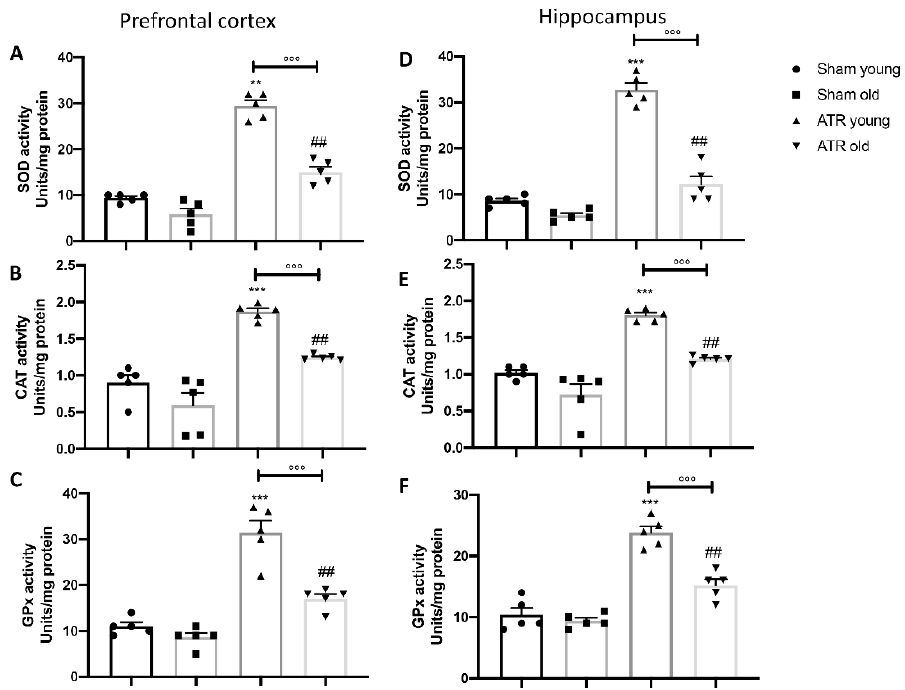
Figure 6. Effect of ATR inhalation on SOD, CAT and GPx activity. By ELISA kit we investigated the effect of ATR inhalation on SOD, CAT and GPx activity in prefrontal cortex ( A–C ) as well as in the hippocampus ( D–F ). After ATR exposure, both young and aged mice showed a significant increase in physiological antioxidant response in prefrontal cortex and hippocampus. Statistical analysis revealed that older mice showed less physiological response than younger mice. Data is expressed as the mean ± SEM of n = 5 animals for each group. ** p < 0.01 vs. Sham young; *** p < 0.001 vs. Sham young; ## p < 0.01 vs. Sham old; °°° p < 0.001 ATR old vs. ATR young.